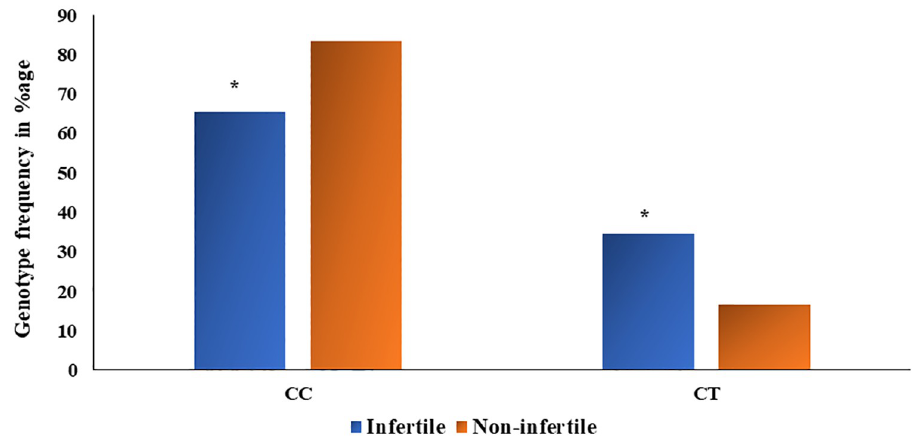
Fig 3. Genotype frequency distribution in percentage (CC and CT) of rs17228602 AChE SNP in infertile and non- infertile male group. ( * significant at p < 0.05).